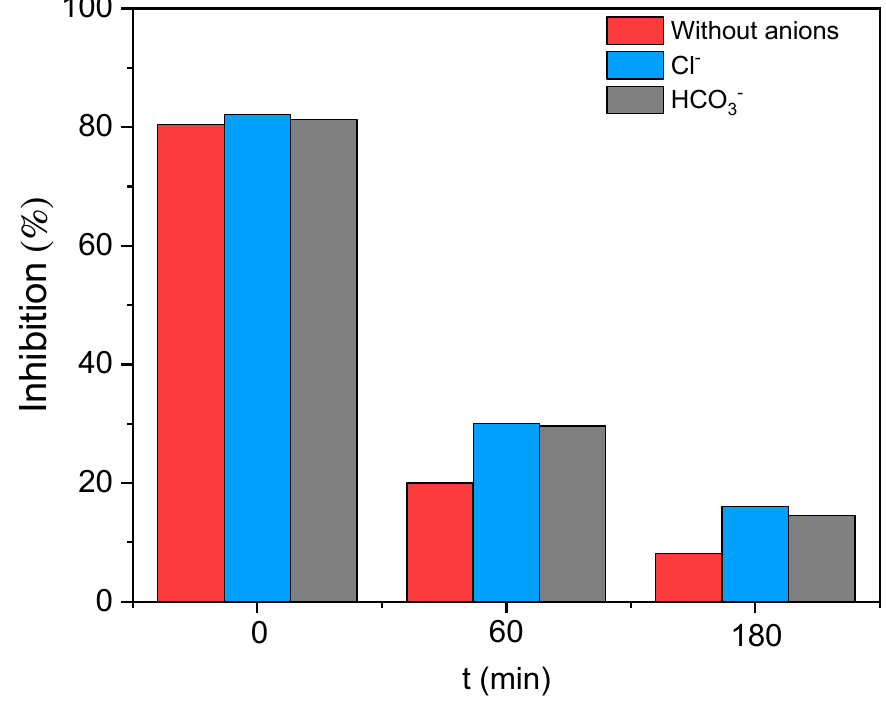
Figure 7. Percentage of inhibition of light emission (I (%)) after 15 min of incubation. Initial and final (t = 60 and 180 min) samples from reactions without and with anions are analyzed. Experimental conditions: Fe = 7.10 mg L − 1 , H 2 O 2 = 290 mg L − 1 , 124–TCB = 28 mg L − 1 , Cl − = 600 mg L − 1 , HCO 3 − = 600 mg L − 1 , and High rad intensity.